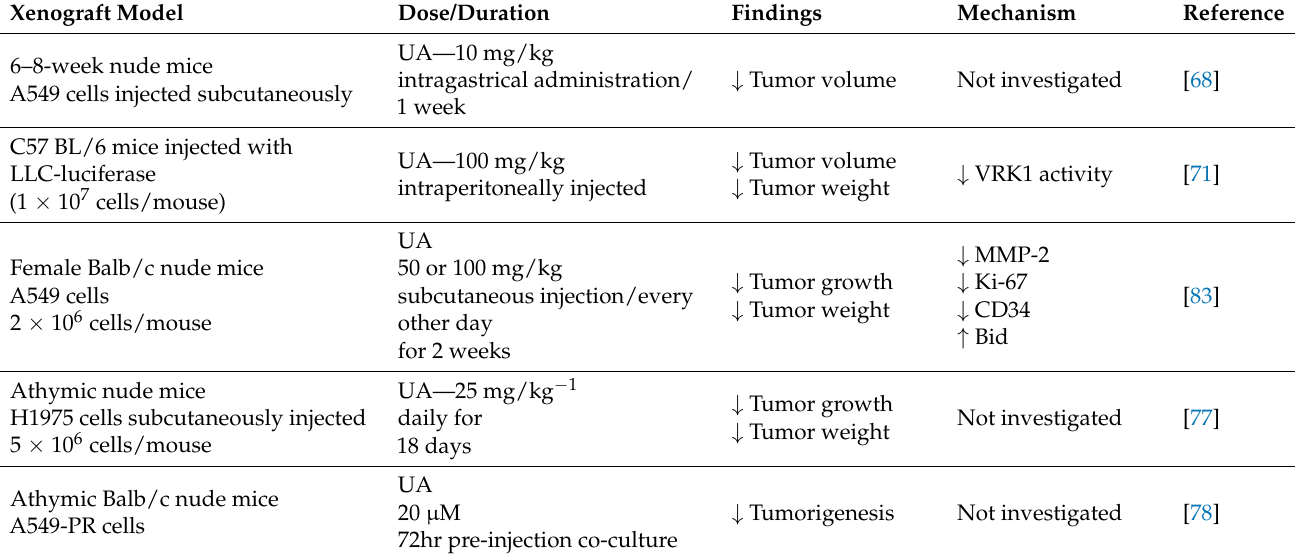
Table 3. Effects of ursolic acid against lung cancer: in vivo